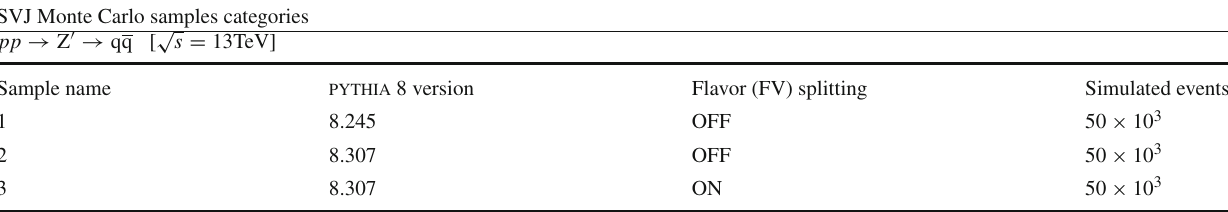
Table 4 SVJ MC samples generated with pythia 8 for a Z (cid:7) mass m Z (cid:7) = 1 TeV. For all these categories, only the decay of the Z (cid:7) to dark quarks is